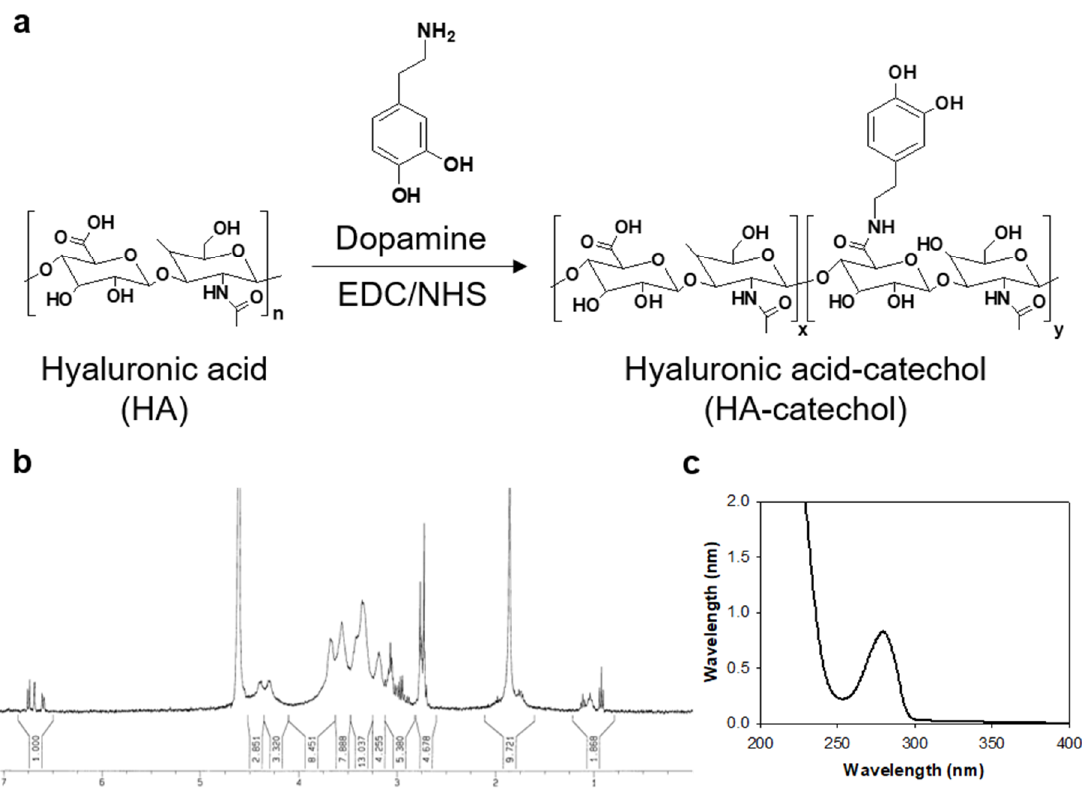
Figure 1. ( a ) Synthesis and chemical structures of hyaluronic acid (HA)–catechol. ( b ) 1 H NMR and ( c ) UV–Vis spectra of HA–catechol.